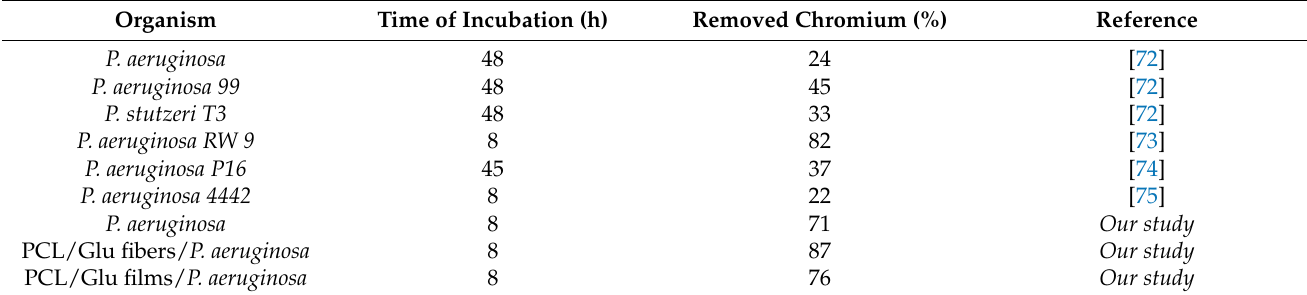
Table 5. Chromium (VI) removal from aqueous solution by P.